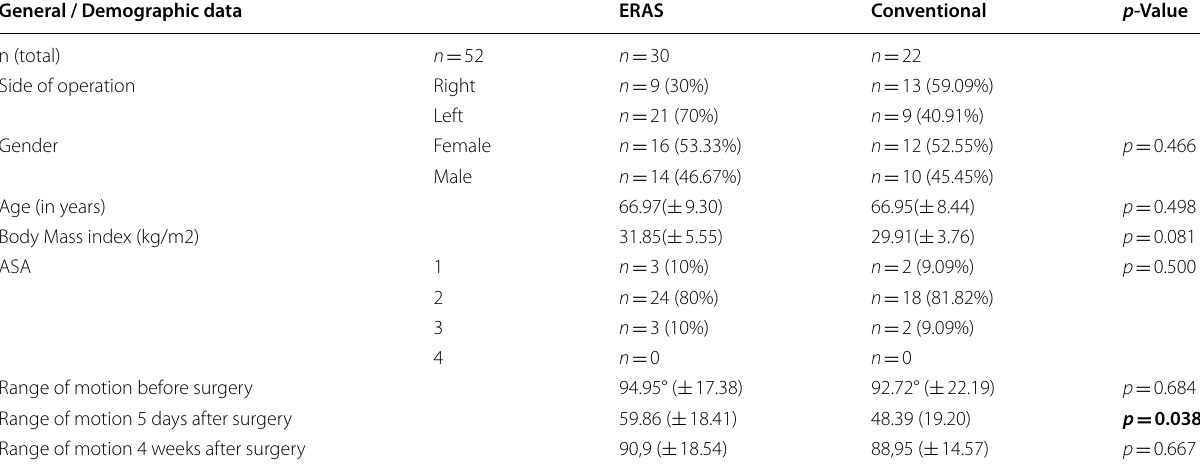
Table 2 General, demographic data and ASA (American Society of Anesthesiologists). Categorial variables were given in absolute numbers/percent and continuous variables in mean